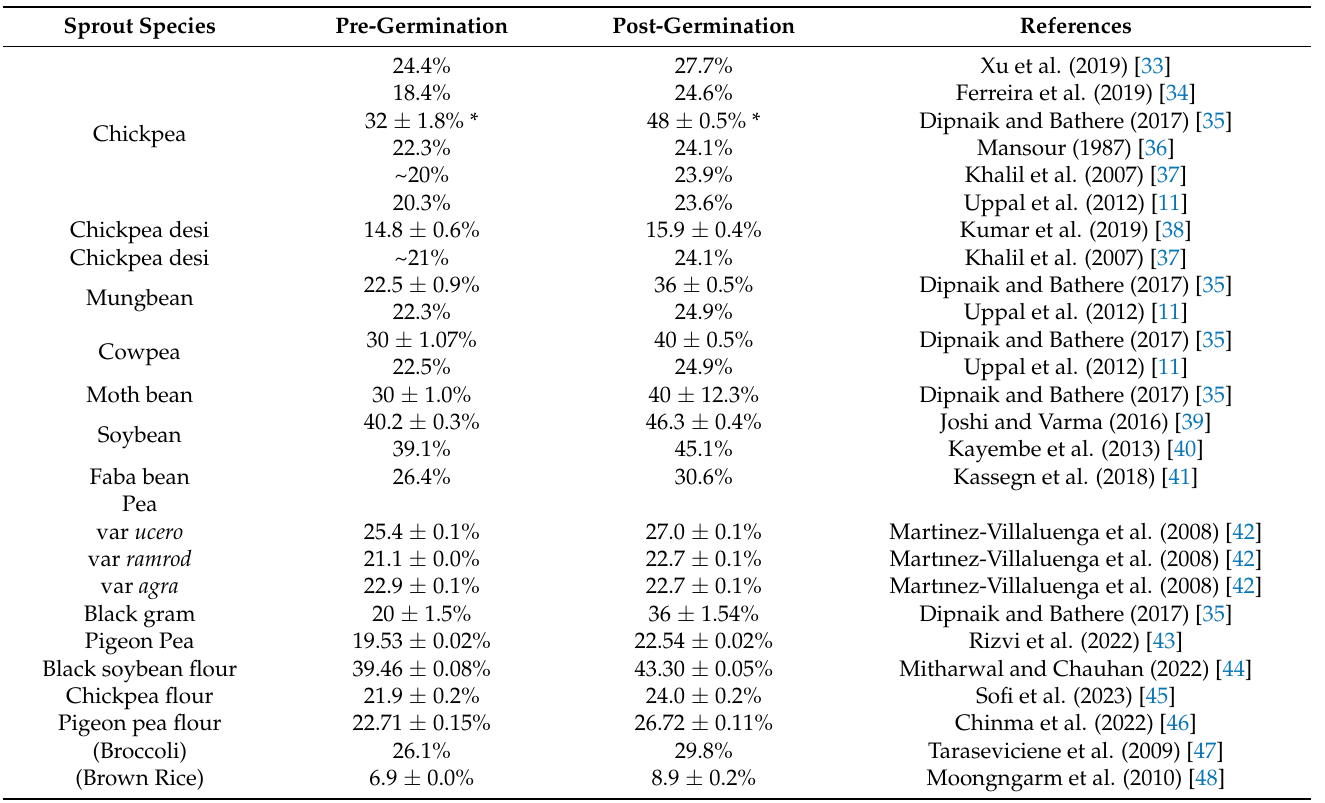
Table 1. Changes in crude protein content after germination (calculated using Kjeldahl method and expressed as a percentage of dry weight, unless stated). Non-legume comparison species are shown in